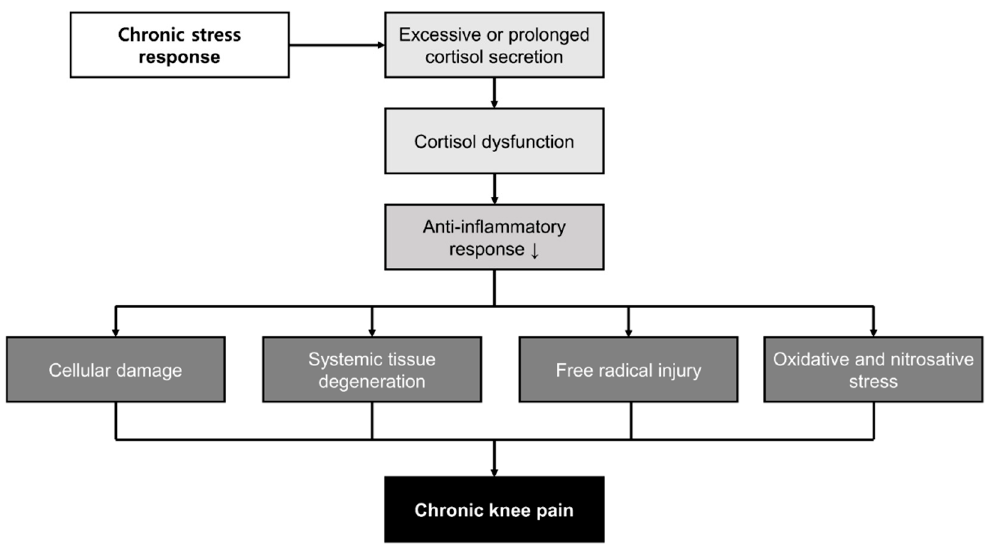
Figure 3. Hypothesis underlying the association between chronic knee pain and psychological stress. Note: “ ↓ ” means